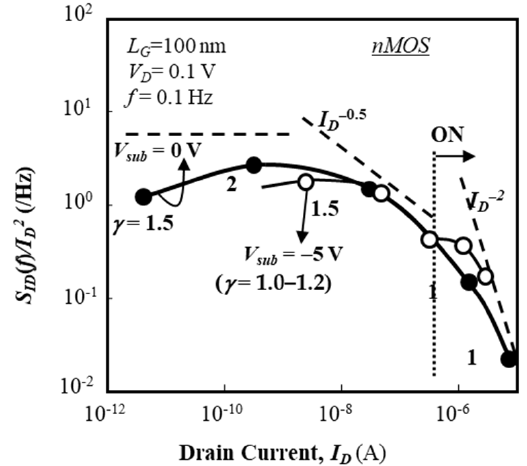
2 ( ) S f I ) of drain current as a D I D